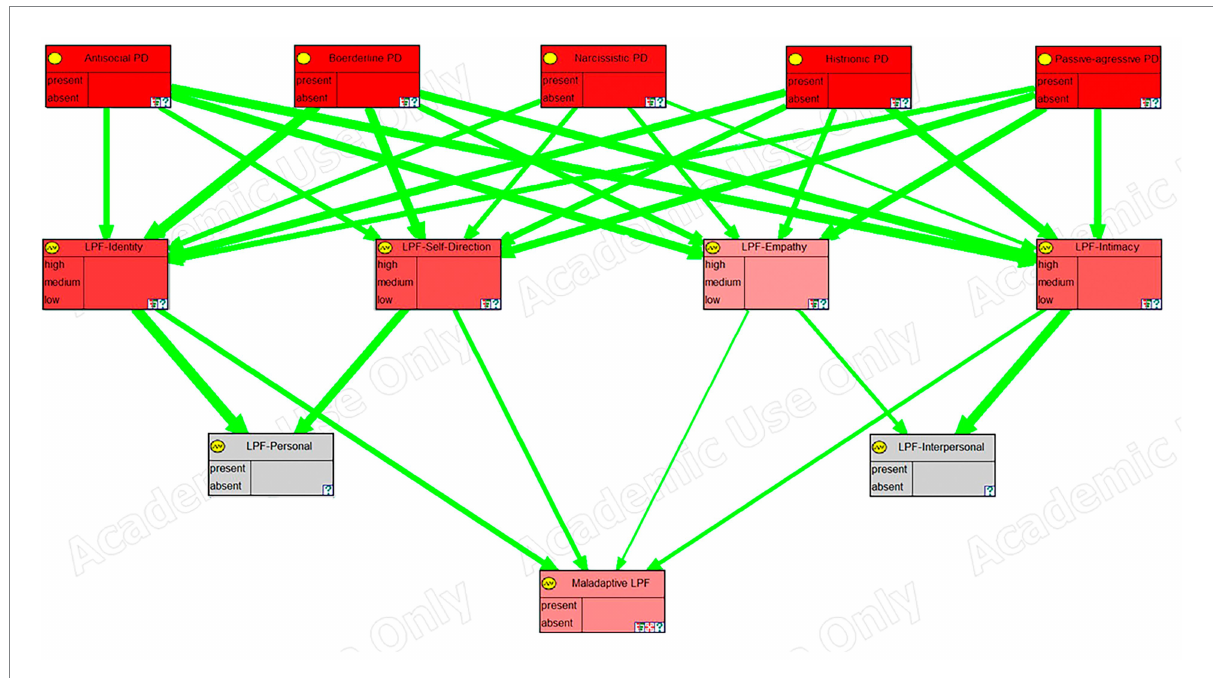
FIGURE 6 Sensitivity analysis, in GeNIE, for level of personality functioning